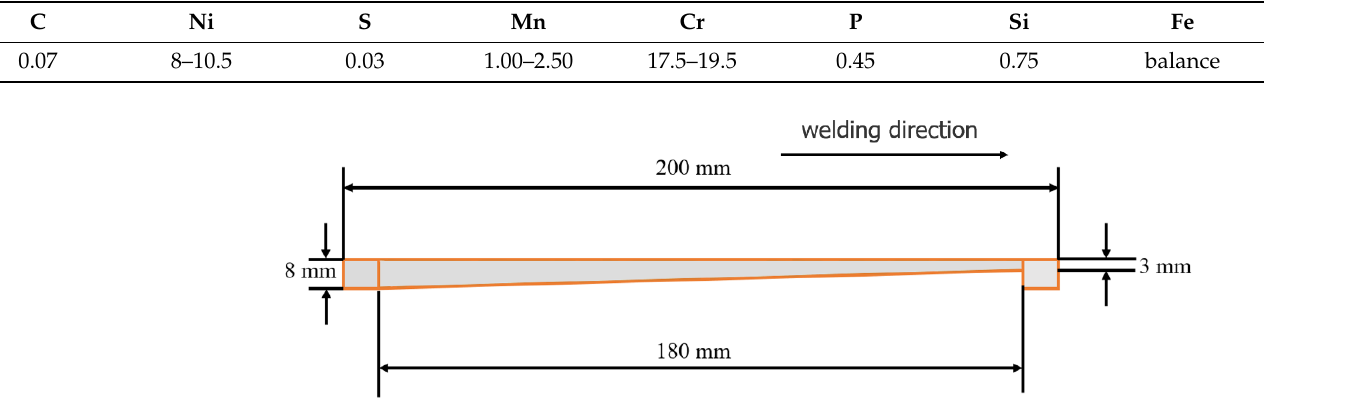
Figure 3. Welding test inclined plate size diagram. Table 2. ER304 welding wire chemical composition table (mass fraction, %).